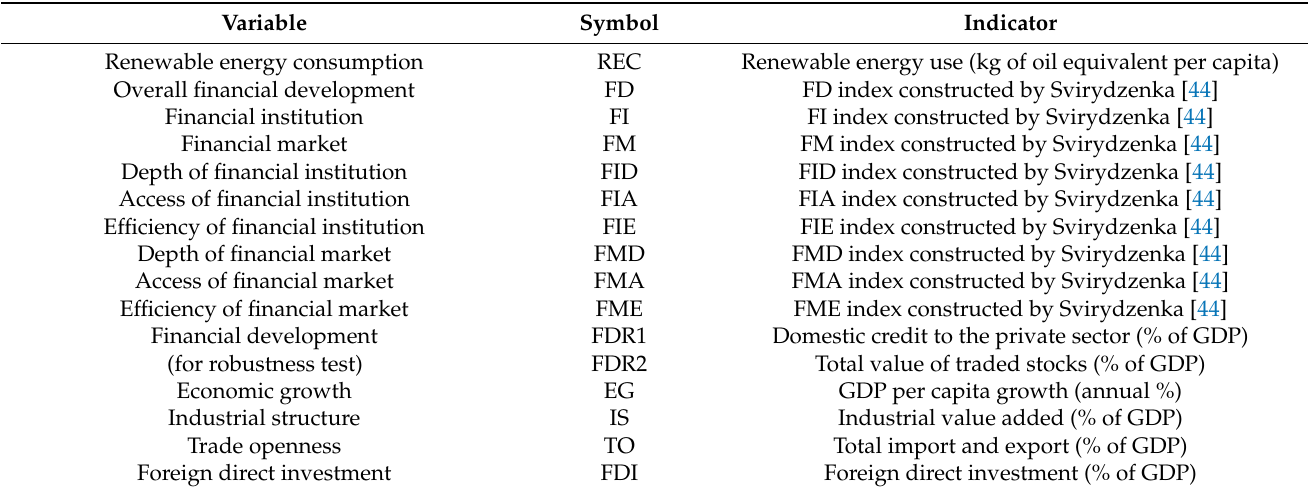
Table 1. Descriptions of